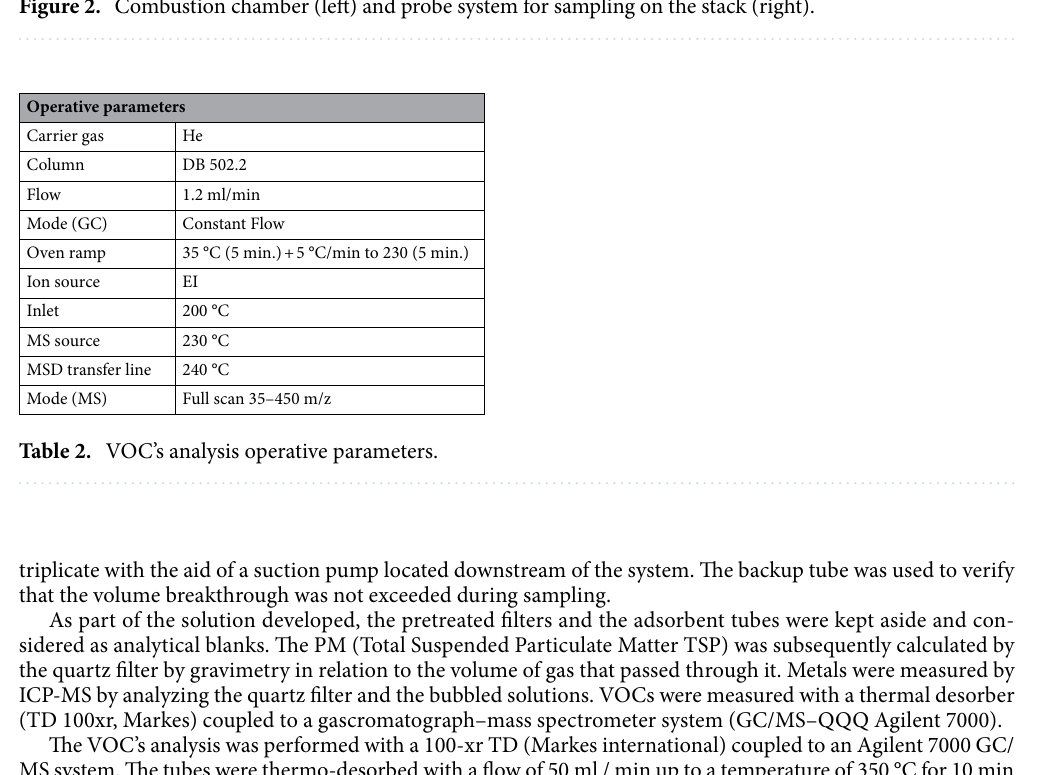
Figure 2. Combustion chamber (left) and probe system for sampling on the stack (right).